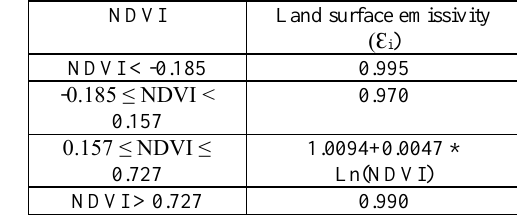
Table 2: Estimation of land surface emissivity from